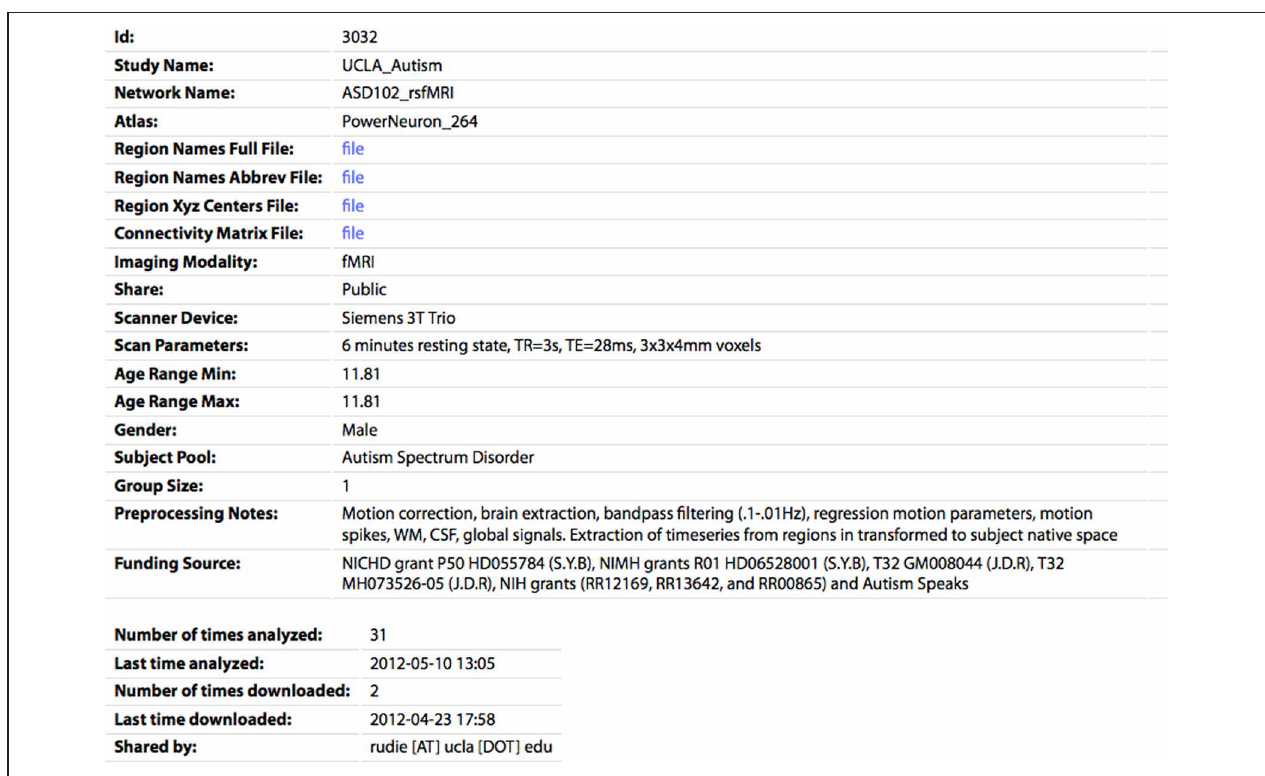
FIGURE 5 | The profile page for an individual CM. All of the parameters specified by the sharer of the data appear’s on this page. The CM and associated files (region names/abbreviations/XYZ centers)